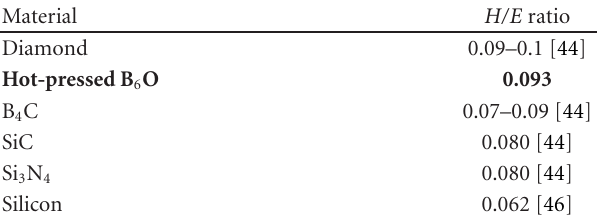
Table 3: H/E ratios of B 6 O and hard ceramic